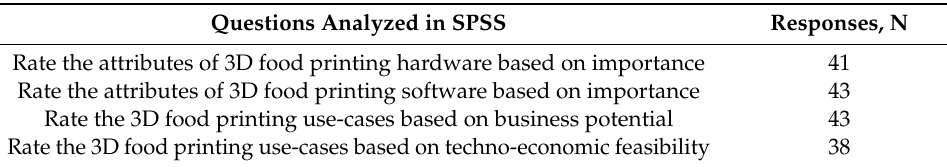
Table 1. Questions and the corresponding number of responses that were analyzed in